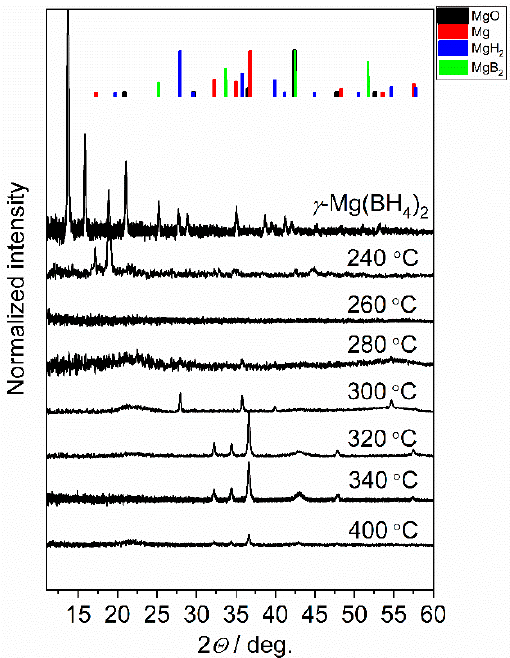
Figure 2. PXRD profiles of as received Mg(BH 4 ) 2 and the samples decomposed at various tempera- tures. The pattern of as received Mg(BH 4 ) 2 corresponds to the porous γ -phase, the pattern recorded after the 240 ◦ C isotherm resembles one of the high temperature phases